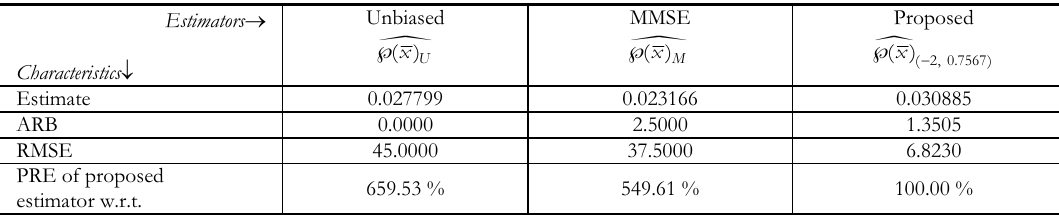
Estimates, ARBs, RMSEs and PREs of competitive estimators for precision of average yield of wheat Estimators